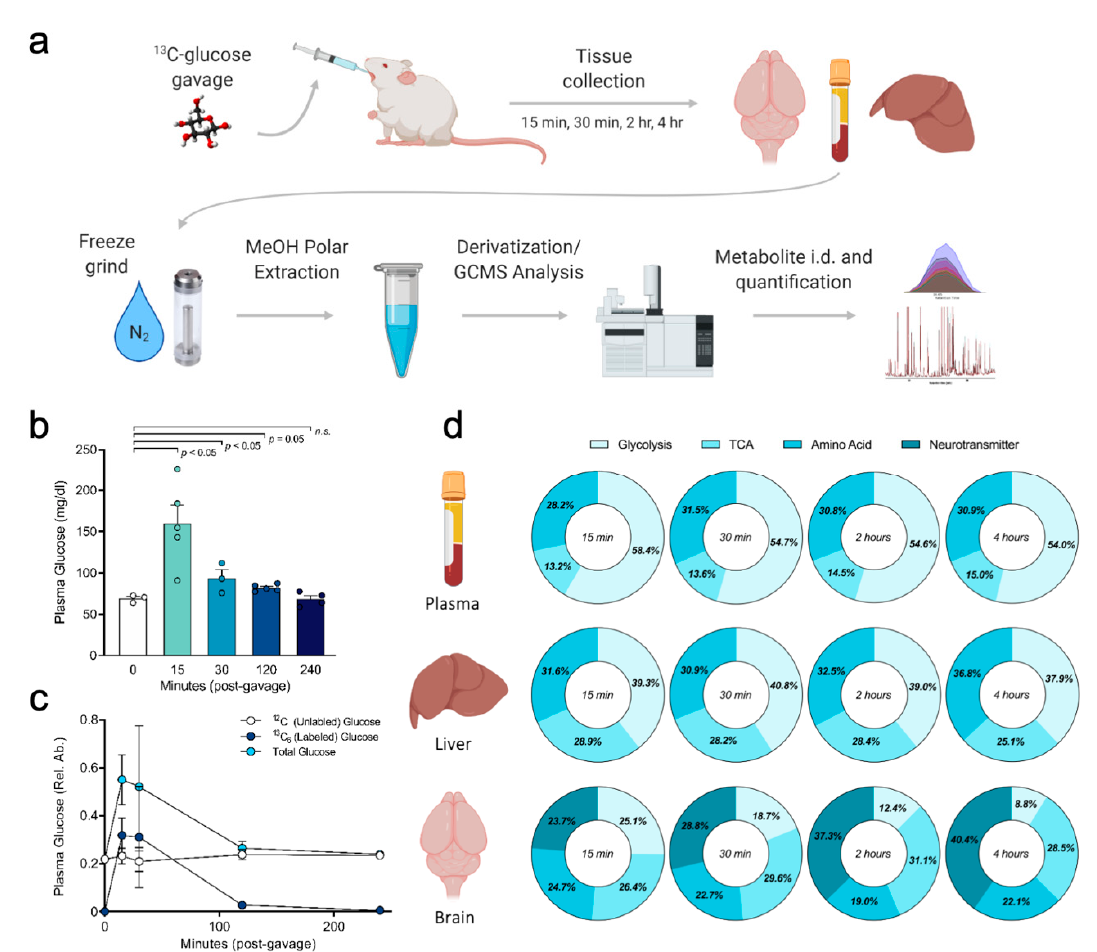
Figure 1. Experimental design, plasma glucose labeling and 13 C pathway distribution analysis after oral gavage of [U- 13 C] glucose. ( a ) Schematic of metabolomics workflow for usage of stable isotope tracer in vivo delivered via oral gavage. Mice were orally gavaged [U- 13 C] glucose tracer (2 mg/kg bodyweight), euthanized 15 min, 30 min, 2 h, or 4 h post-gavage, tissues and plasma promptly collected and frozen in liquid nitrogen. Tissues were machine-ground under liquid nitrogen after which tissue (or plasma) polar metabolites extracted with MeOH, vacuum dried, derivatized, and analyzed via GCMS. Data interpreted using AMDIS and DExSI software for determining pathway enrichment. ( b ) Total plasma glucose was measured via colorimetric assay to determine plasma glucose concentration pre- and post-gavage (each time point represents one group of mice). ( c ) Plasma glucose measured via GCMS reveals labeled versus unlabeled glucose at each time point. ( d ) Pathway distribution analysis of 13 C enrichment within specific metabolic pathways in plasma, liver, and brain. The average 13 C fractional enrichment across representative metabolites from glycolysis, tricarboxylic acid (TCA) cycle, amino acids, and neurotransmitters were calculated, and shown as the percent of total 13 C enrichment across these pathways for each tissue. Values shown are mean ± SEM ( n = 3–5). Data analyzed by unpaired t -test, p values shown on graph ( b ).